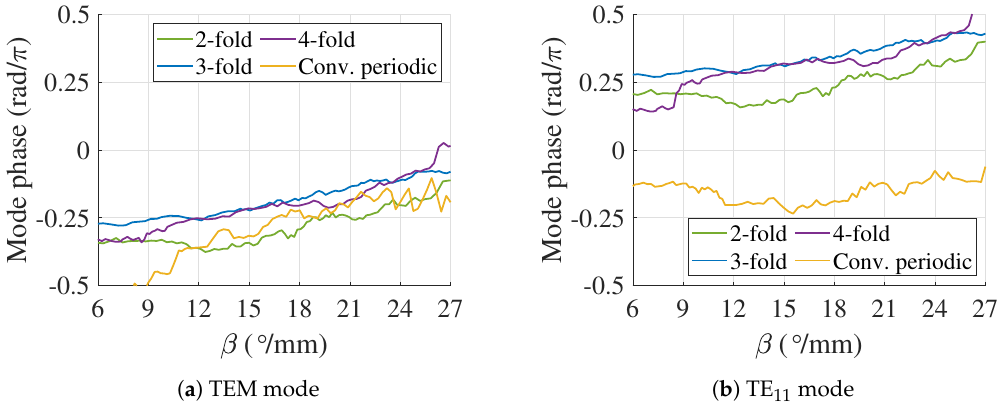
Figure 7. Phases of the mode coefficients of the: ( a ) TEM and ( b ) TE 11 modes. In this simulation, the dimensions and number of modes are the same as in Figure